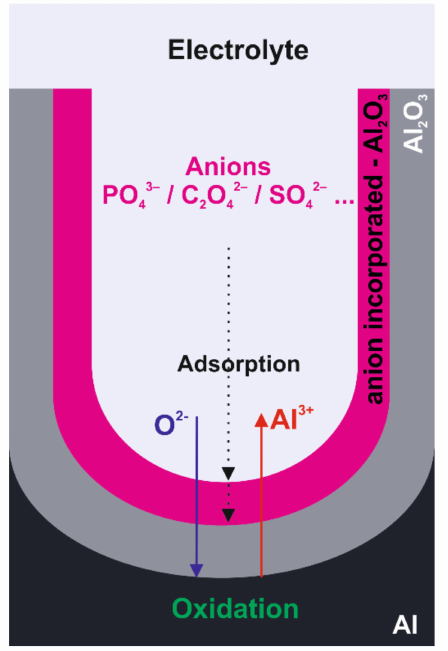
Figure 4. Schematic representation of the mechanism of AAO formation and anion